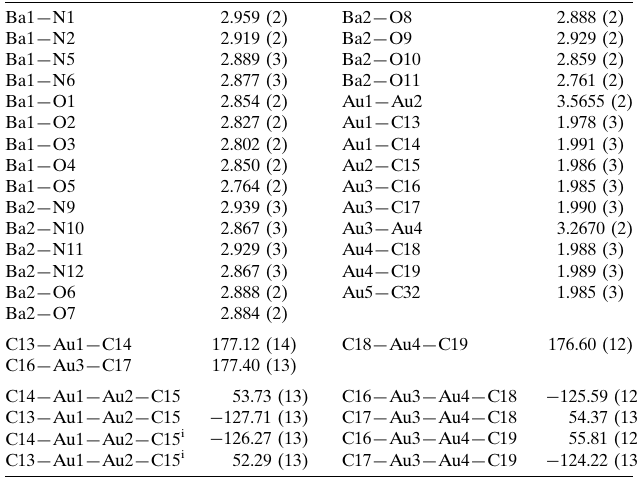
Selected geometric parameters (A˚ , (cid:3) ).